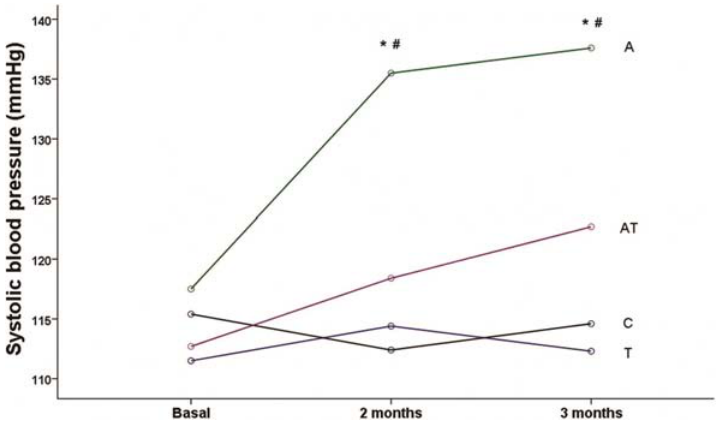
Figure 1. Effect of nandrolone decanoate (A), taurine (T) and their combination (AT) on systolic blood pressure (SBP) of rats. There was a signi fi cant increase of SBP at 2 and 3 months vs basal SBP only in the A group. SBP was signi fi cantly higher in the A vs control (C) group and also in the A vs AT group (n=8 for each group), at 2 and 3 months (General Linear Model; repeated measures; and Bonferroni ’ s post hoc test). *P p 0.002 vs basal blood pressure; # P p 0.007 vs the C and AT